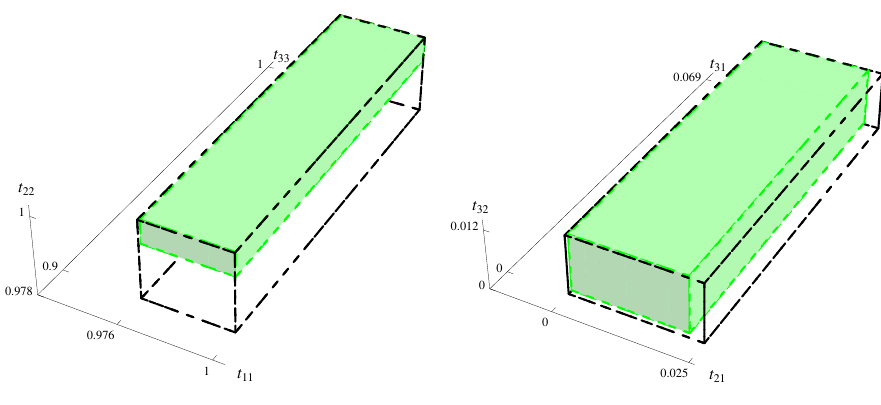
Figure 3 . Values of the t-matrix obtained in the (cid:12)rst step for the scenario with one additional neutrino and mass case (II) (green cuboid) compared with experimental limits (black-dashed cuboid). On left (right) the diagonal (non-diagonal) entries of the t-matrix are